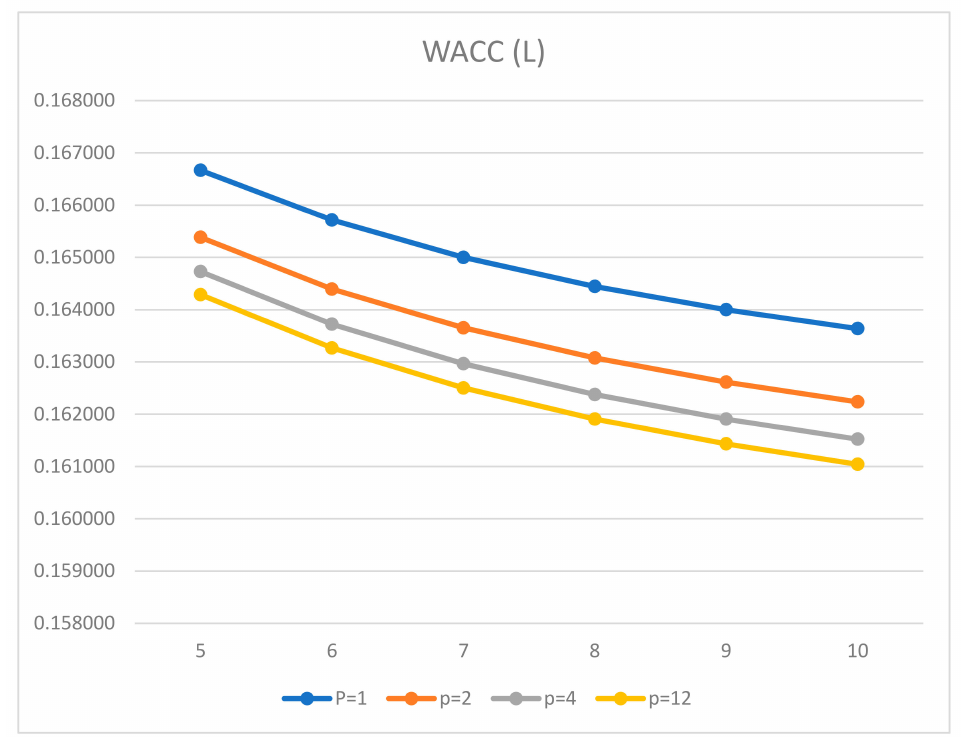
Figure 2. Dependence of the weighted average cost of capital ( WACC ), on leverage level L at different frequency of payment of tax on profit p and fixed k d = 0.16 (larger scale).